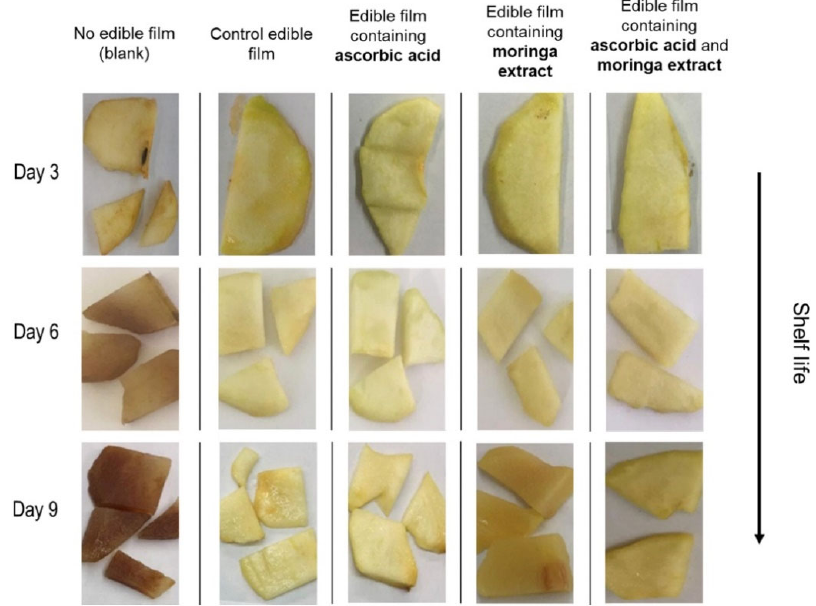
Figure 3. Changes in the colour of pear samples packed in different antioxidant papaya edible films. Reproduced from [53] with permission from Elsevier B.V.